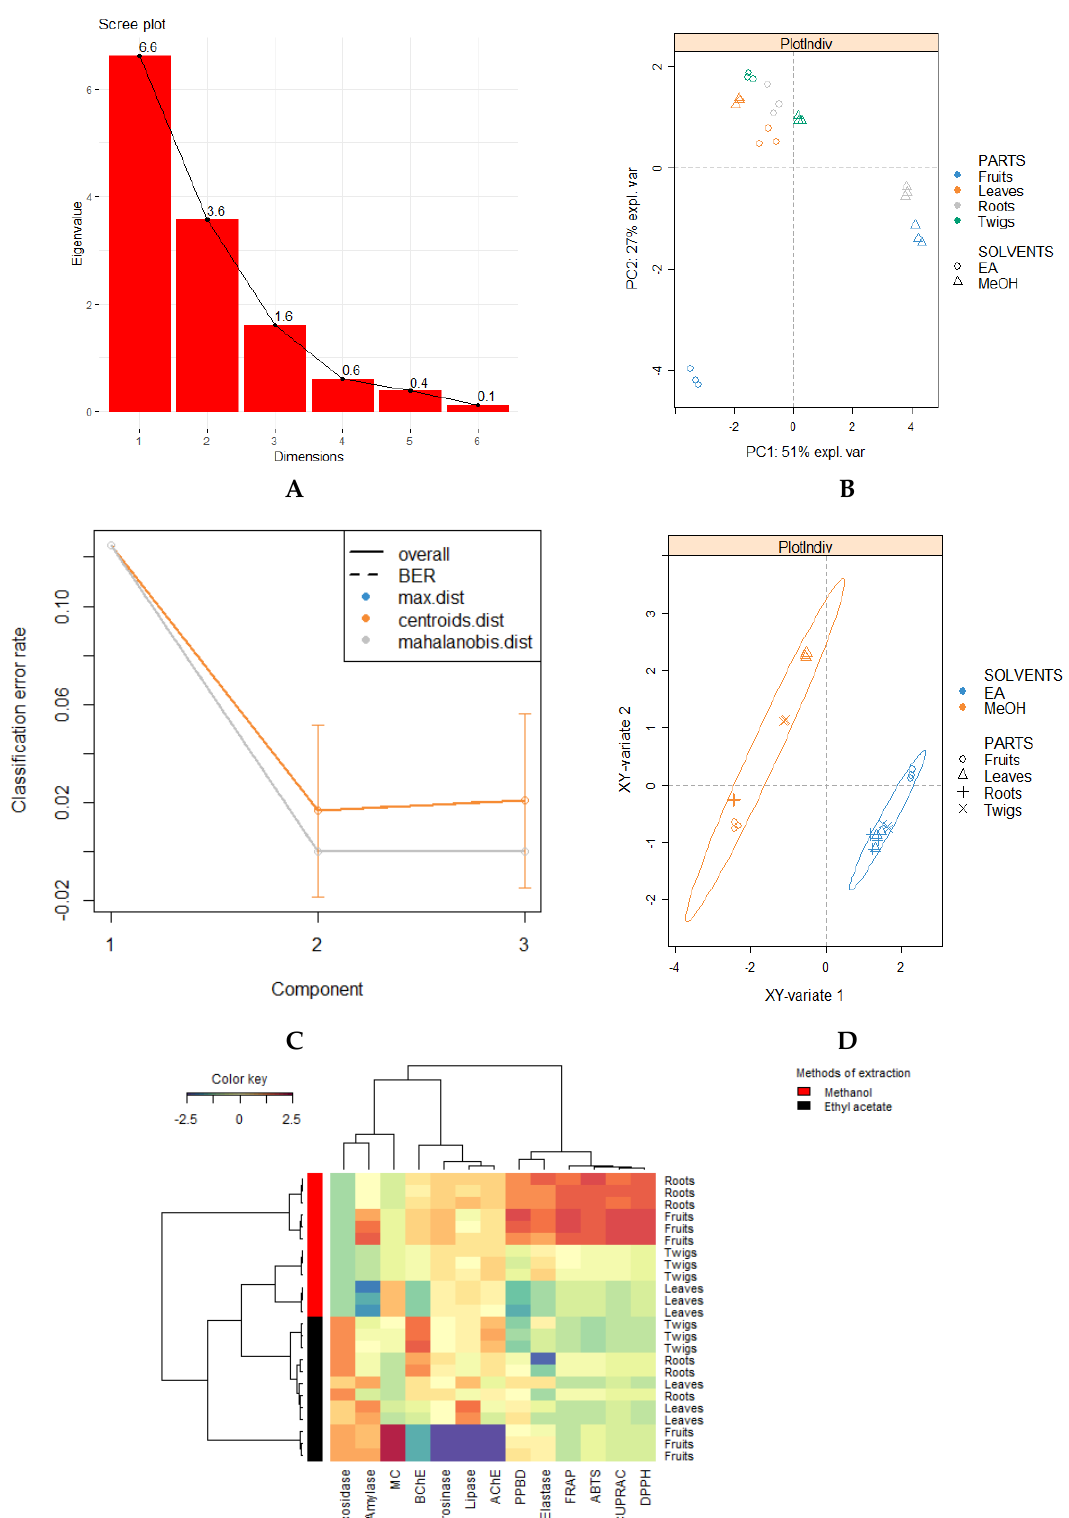
Figure 3. ( A ) Scree plot; ( B ) factorial plan 1–2 of the principal component analysis (PCA); ( C , D ) performance plot and Sparse Partial Least Squares (sPLS-DA) plot from results obtained from biological activities; ( E ) hierarchical cluster analysis shown as a heatmap.